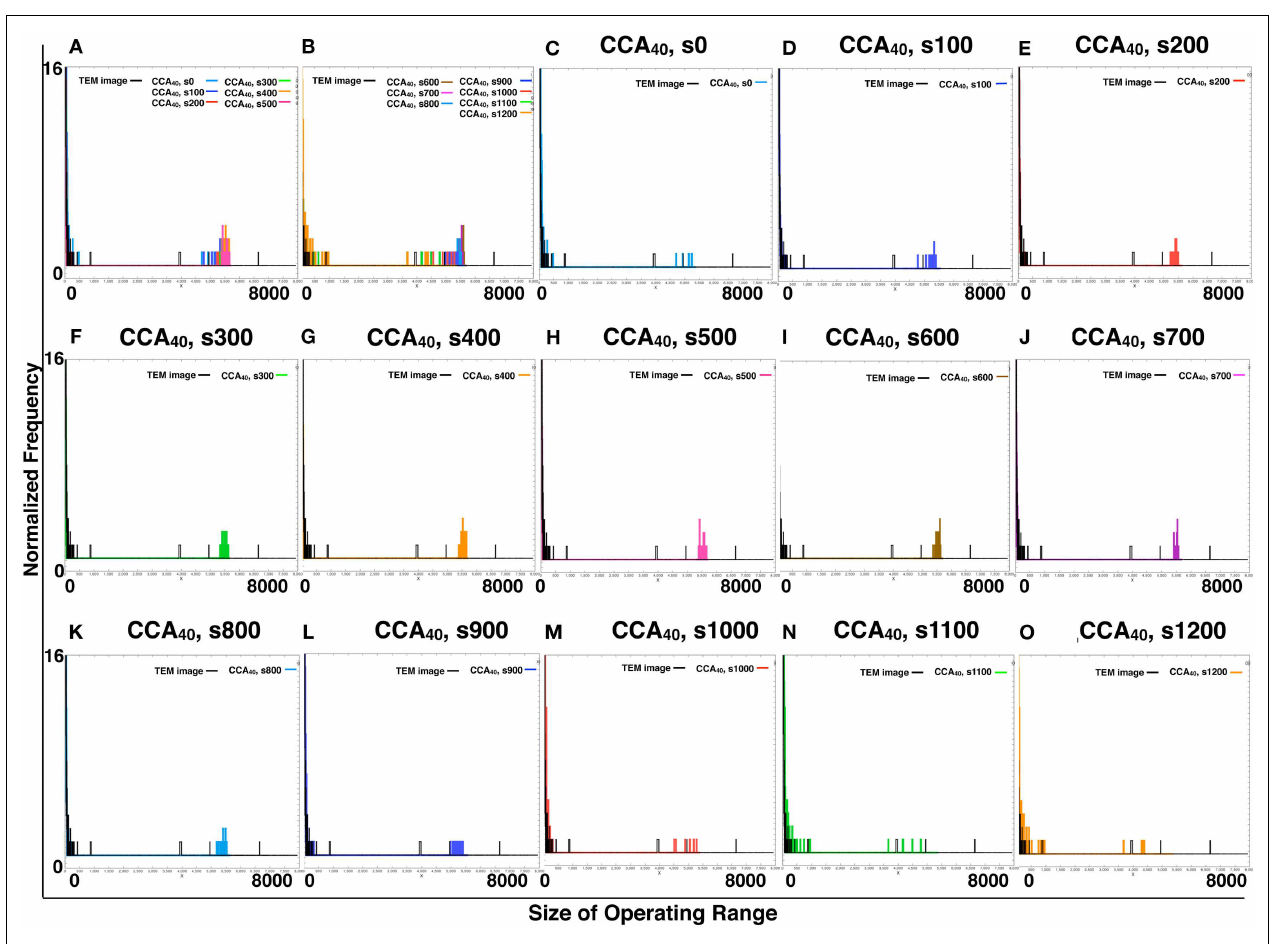
s0–s500 and s600–s1200, with the size of distribution of operating range ofTEM images.The x -axes show the size of operating range (0–8000).The y -axes show the normalized frequency (0–16). (C–O) Showed only two lines in one panel.The size of the distribution of the operating range of one of the models among CCA 40 , s0–s1200, and a TEM